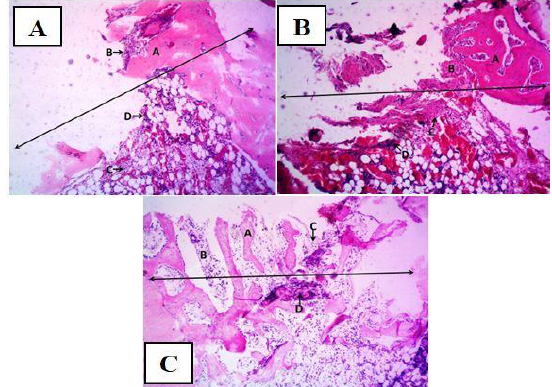
Fig.1: A: Photomicrograph of femur bone of control group (14 days) shows the site of the hole (↔) with the presence of new trabecular bone formation , scanty amount of woven bone, connective tissue formation and inflammation (score 2). B: Photomicrograph of femur bone of local treated group (14 days) shows the site of the hole (↔) with the presence of new trabecular bone. C: Photomicrograph of femur bone of systemic treated group (14 days) shows the site of the hole (↔) with the presence of new trabecular bone formation , woven bone , connective tissue formation , and inflammation (score 2).